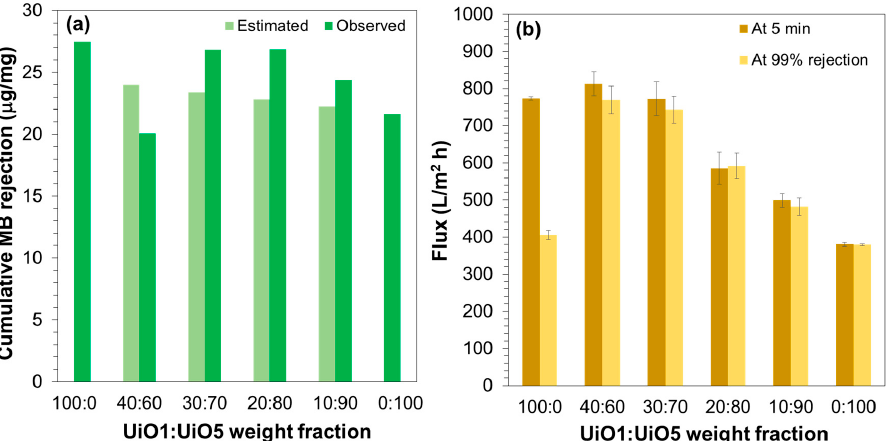
Figure 8. Filtration performance of bimodal composite membranes: ( a ) Cumulative rejection for the filtration of 350 mL of the MB aqueous solution; ( b ) permeability compared by the flux values at the